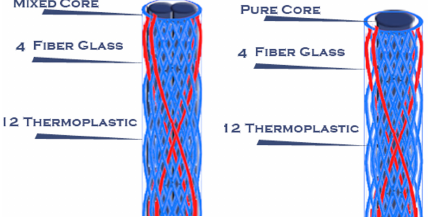
Figure 8. Samples 6 and 7 with different